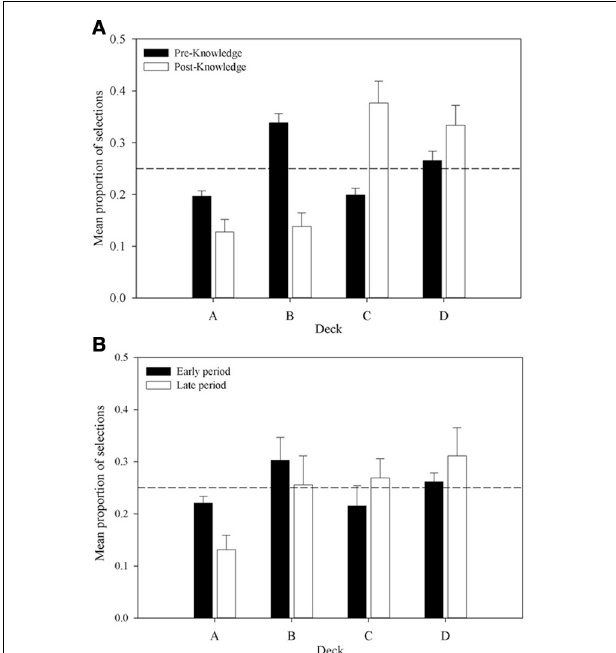
FIGURE 6 | Mean proportion of cards selected from each deck in (A) the pre- and post-knowledge periods for participants who displayed knowledge ( n = 27), and (B) the comparable periods for participants who did not display knowledge ( n = 5). Error bars are the standard error of the mean. The dashed line represents chance selection.